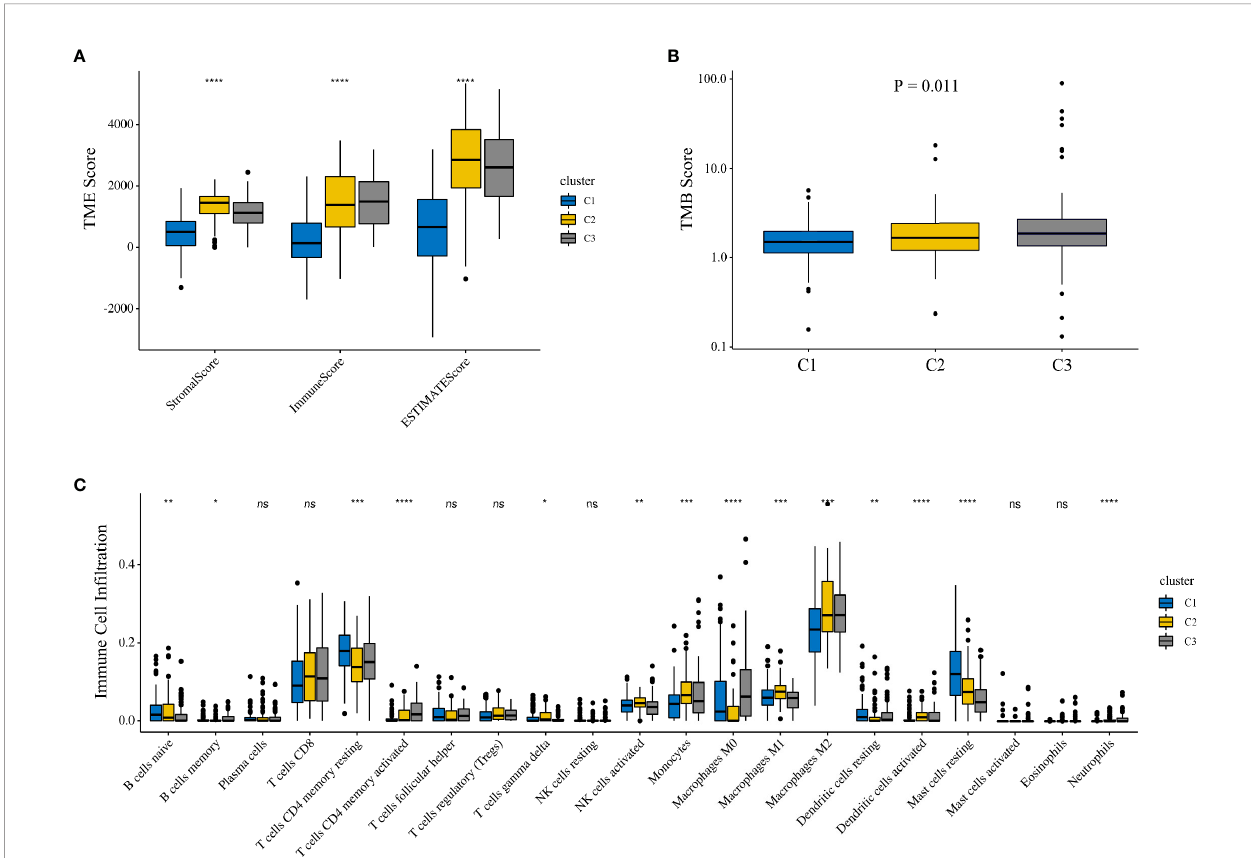
FIGURE 2 | Comparison of the TME among different clusters. (A) The Kruskal – Wallis test was used to compare the TME-related scores between the three clusters. (B) Comparison of TMB among three clusters. (C) Comparison of 21 immune cells between the three clusters. TME, tumor microenvironment; TMB, tumor mutation